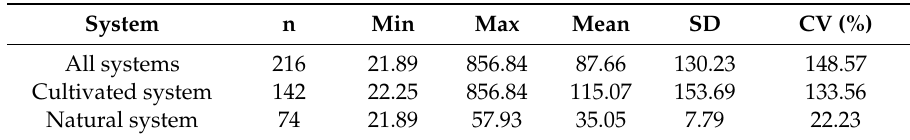
Table 3. Summary statistics for soil oxalate-extractable P content (mg P kg − 1 soil) obtained by chemical analysis by